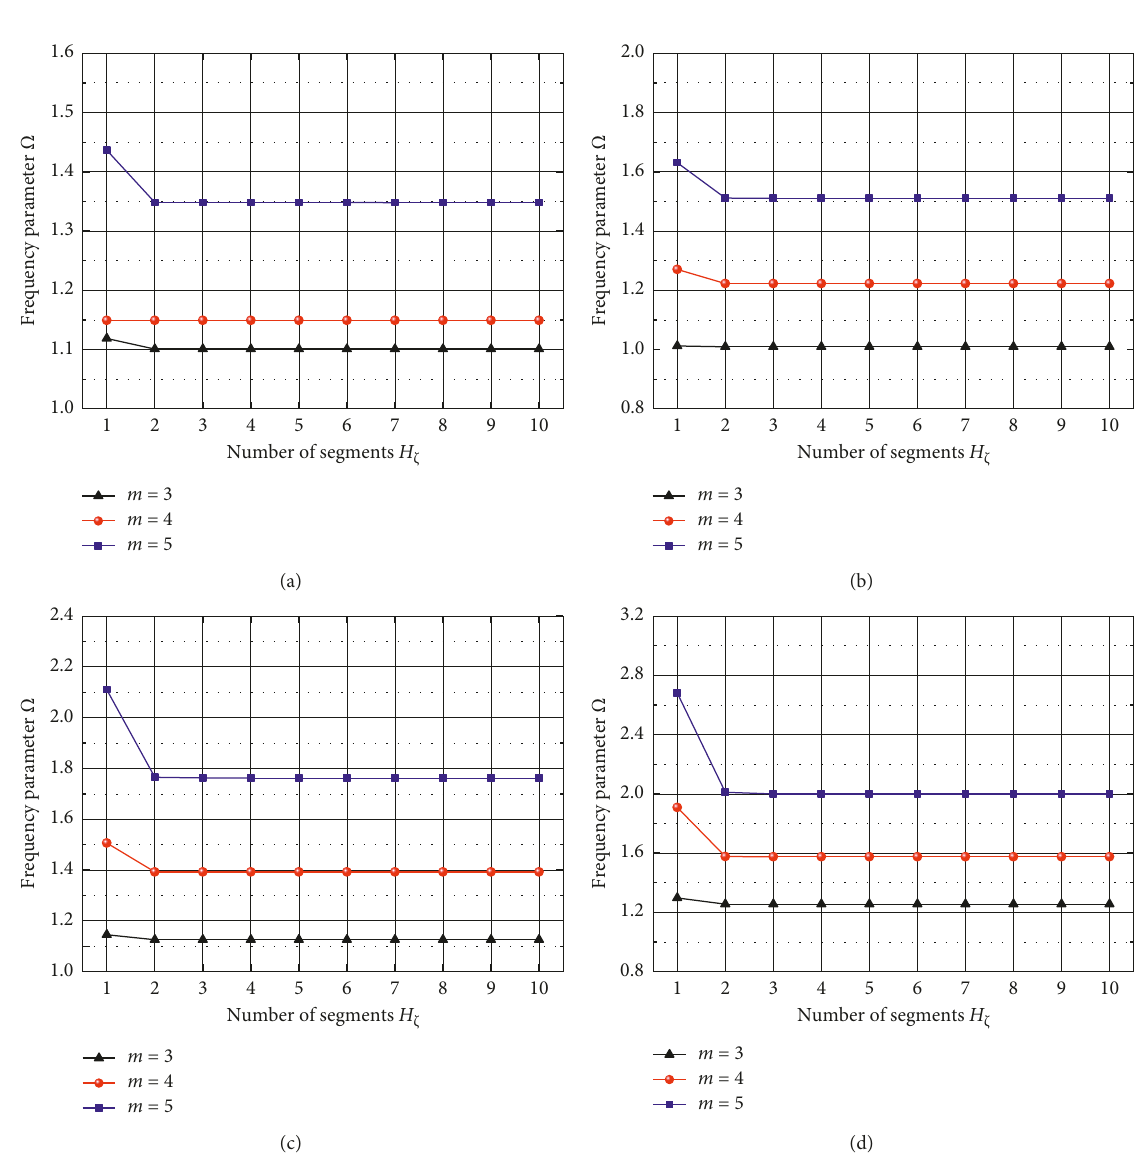
Figure 5: Frequency parameters